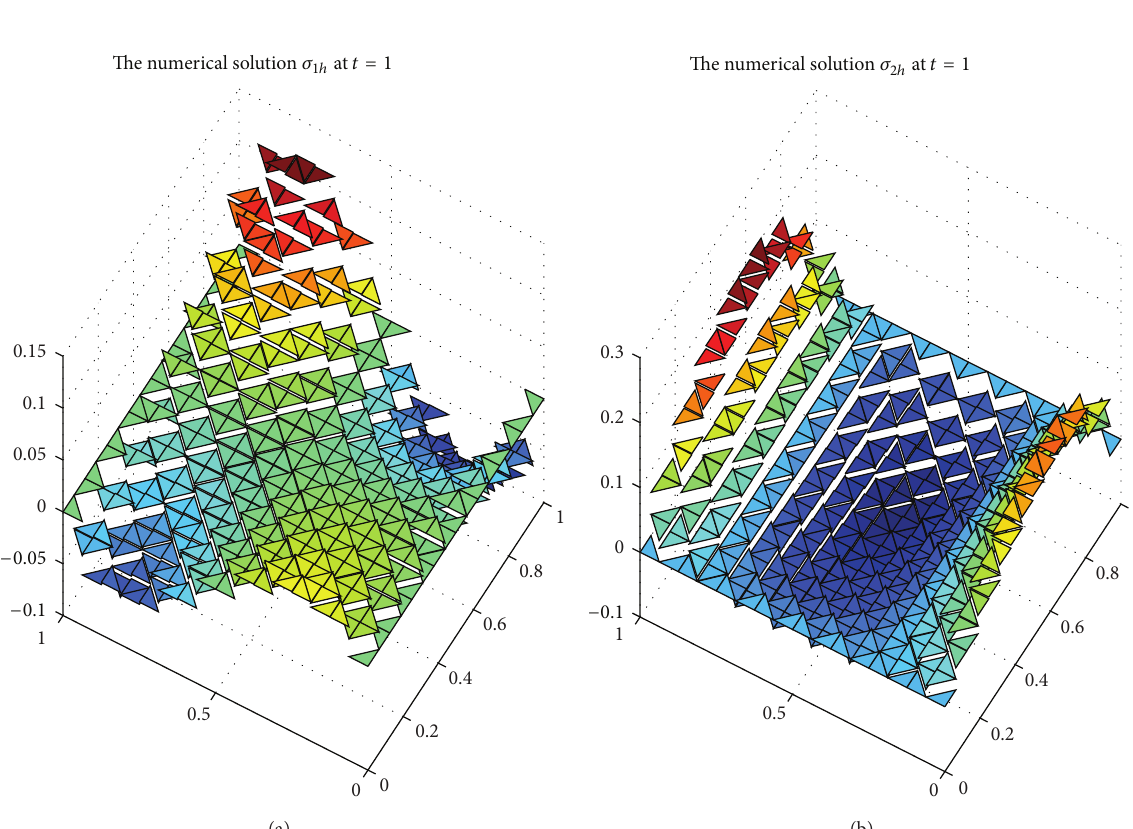
Figure 5: The surface for the exact solution 𝜎 = (𝜎 1 , 𝜎 2 ) .